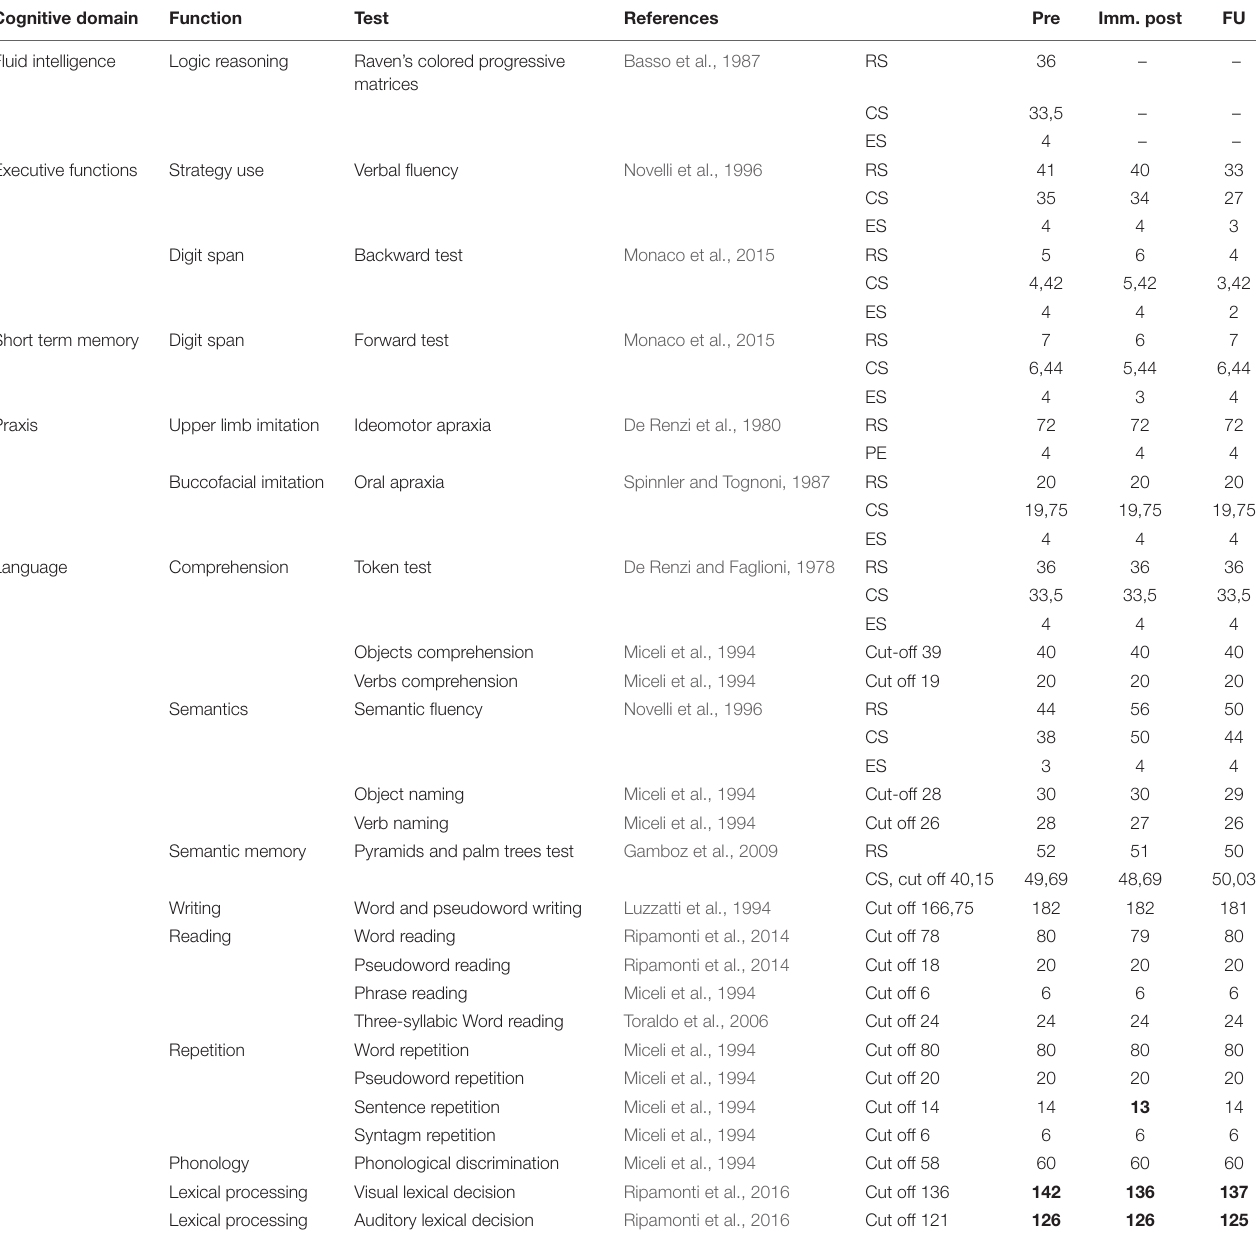
TABLE 1 | Neuropsychological status of the patient: presurgery, immediately postsurgery (imm. post), and at follow-up. Cognitive